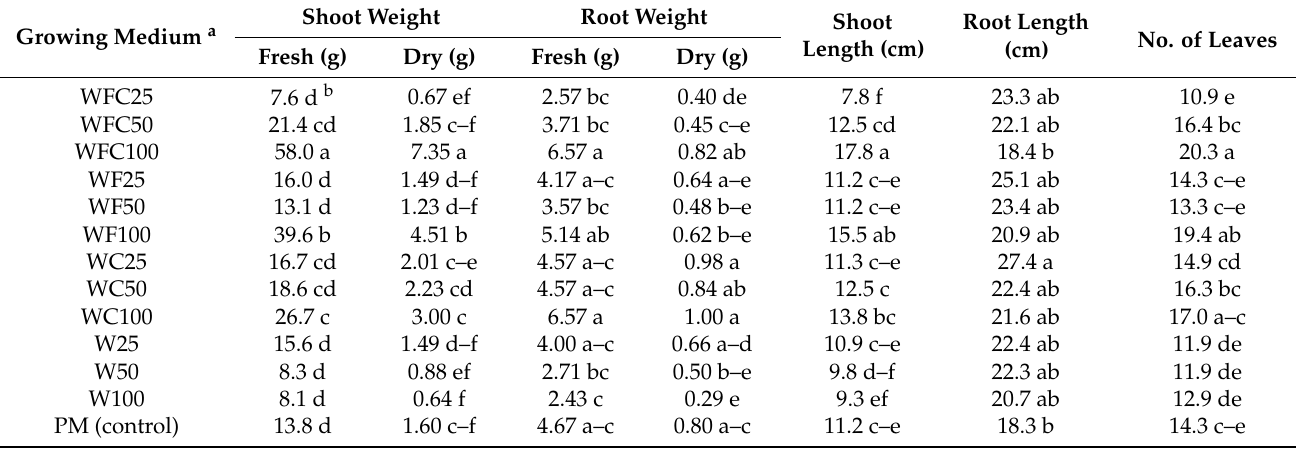
Table 4. Effects of growing media on shoot and root growth and number of leaves of lettuce ( Lactuca sativa ) cv. Starfighter in Trial 1.